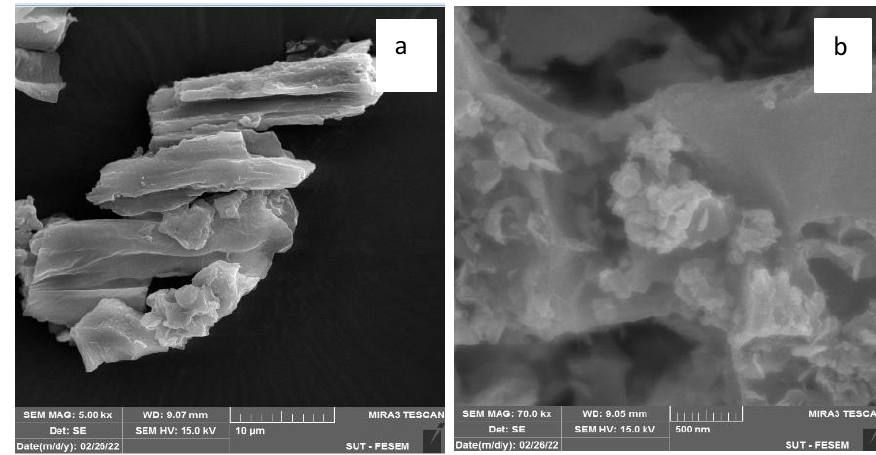
Fig. 1. SEM images of (a) Alhagi powder (b) Alhagi activated carbon